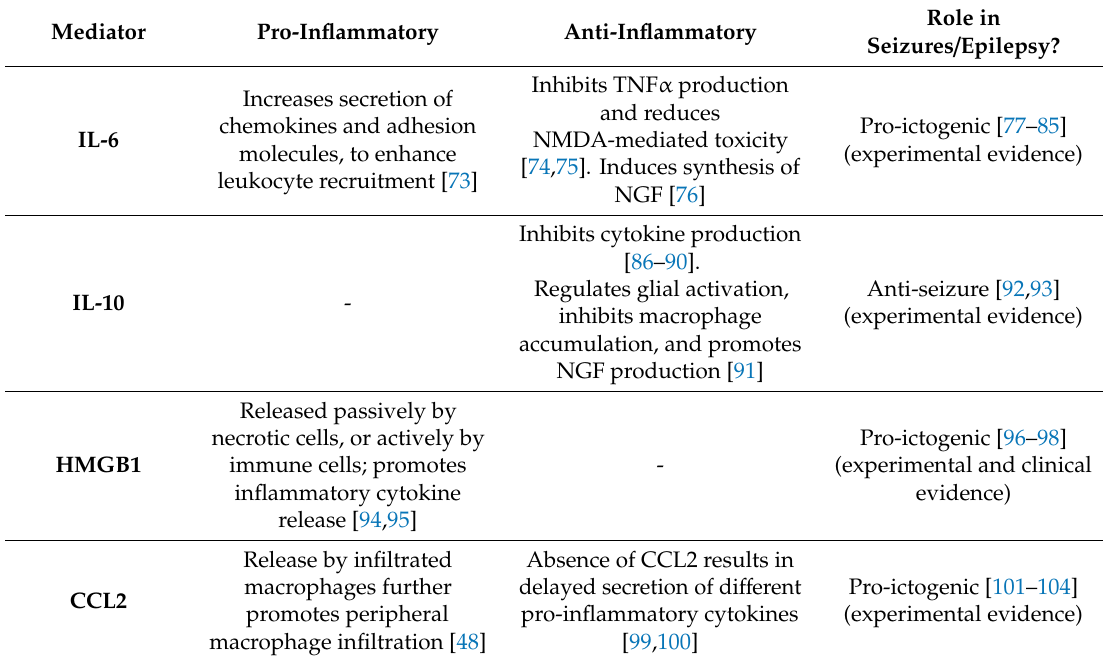
Table abbreviations: Blood-brain barrier (BBB); CC chemokine ligand 2 (CCL2), high mobility group box protein-1 (HMGB1), interleukin-1 (IL-1), nerve growth factor (NGF), N-methyl-D-aspartate (NMDA), reactive oxygen species (ROS), tumor necrosis factor alpha (TNF α